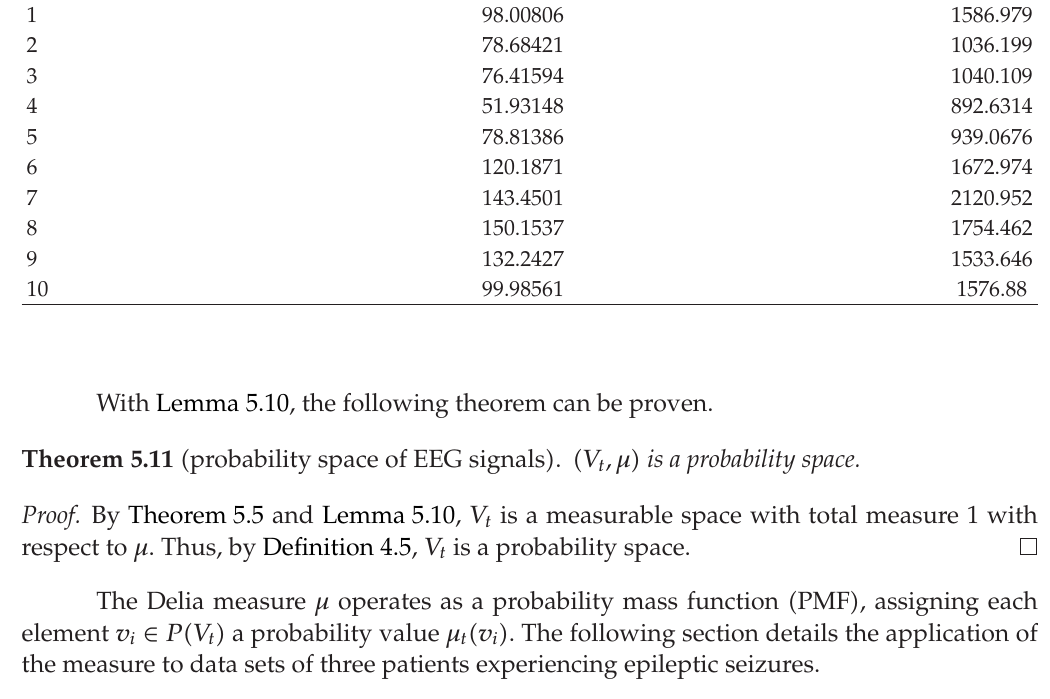
Table 2: Emulated baseline and jitter values for a 10-second seizure (cid:5) Patient A (cid:6) . Time (cid:5) t